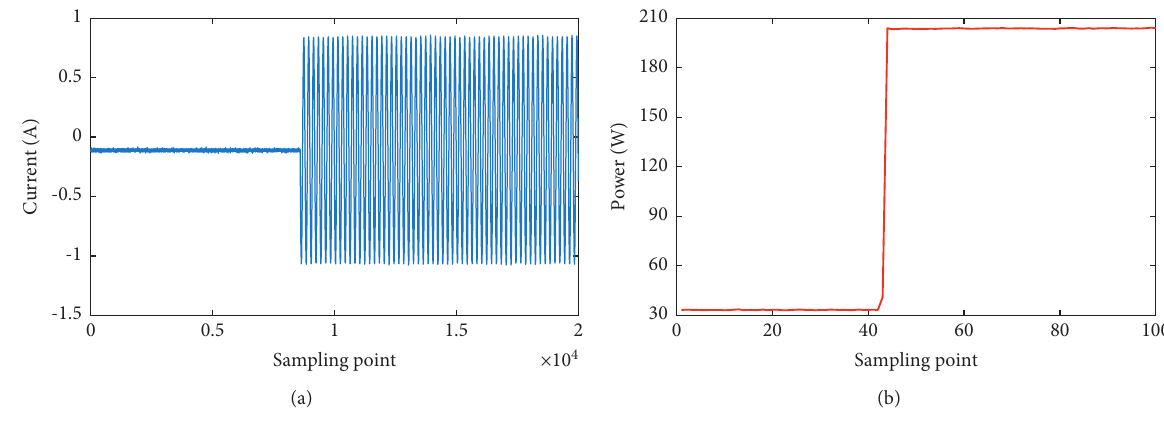
Figure 2: Load step change. (a) Current. (b) Power.